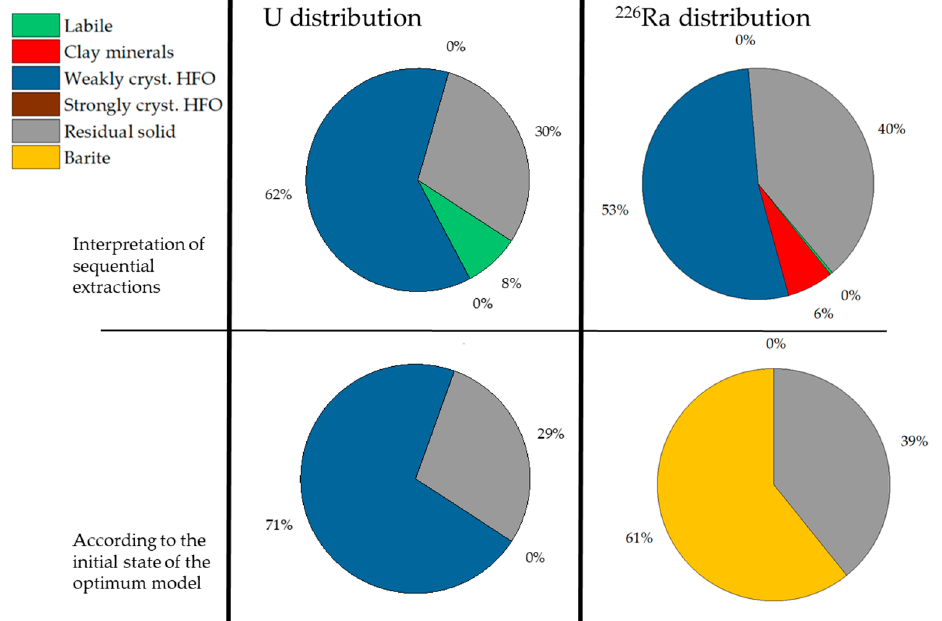
Figure 6. U and 226 Ra initial distribution in the C1P3B sample according to the direct interpretation of the sequential extraction results (the concentrations in the leachates) and the initial state model (the thermodynamic equilibrium between the minerals present and the pore water) (cryst.—crystallized, HFO—hydrous ferric oxyhydroxides).